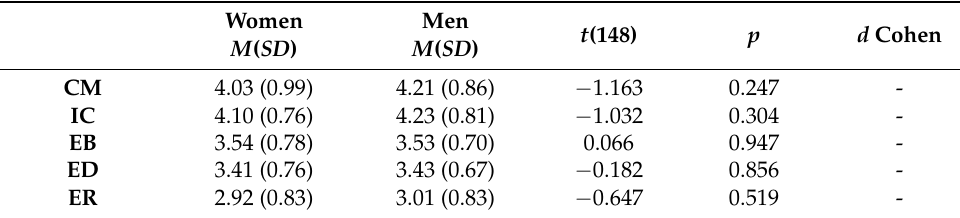
Table 9. The differences between first-time parents in terms of intensity of identity processes.